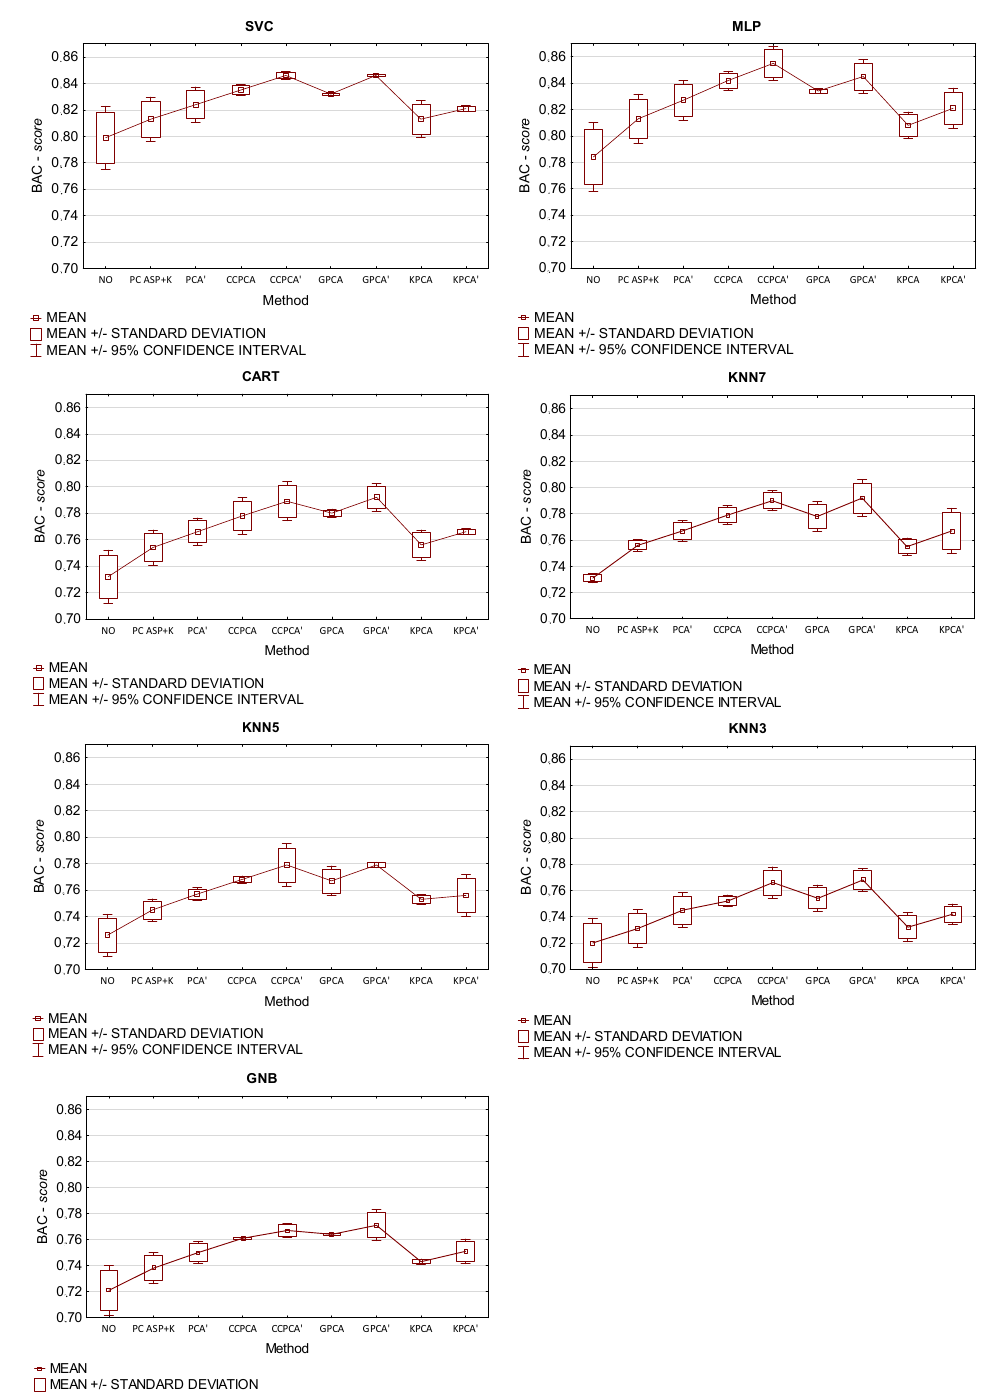
Figure 6. Statistics of experiment 3 for the case of using the proposed method of determining the number of components and features in various extraction methods with the BAC- score